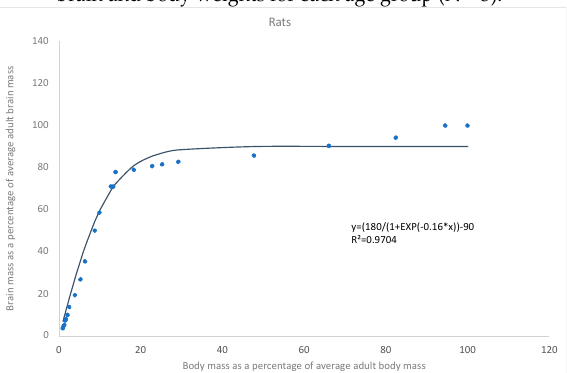
( f ) Brain growth in cats (Felis catus). Data points represent averages of brain and body weights for each age group (N = 3).